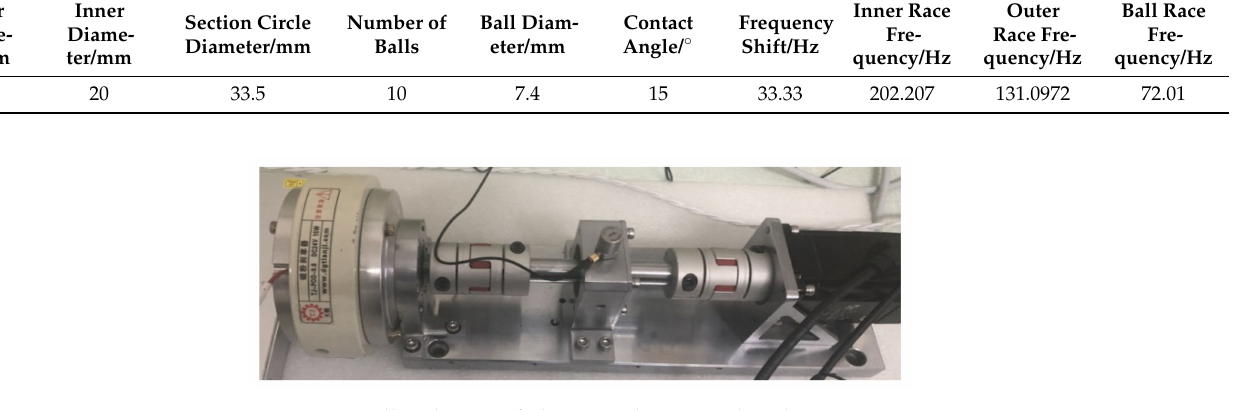
Figure 18. Rolling bearing failure simulation test